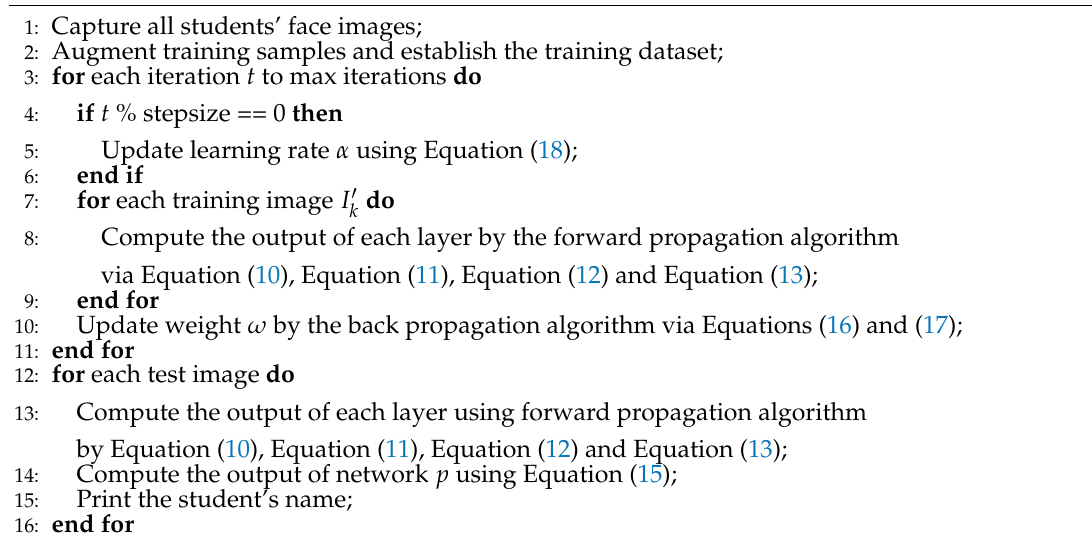
Algorithm 1 Class attendance taking using a convolutional neural